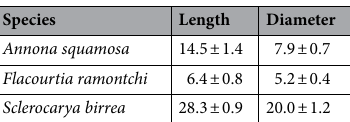
Table 3. Mean seed sizes (with standard deviation) in mm; N = 10 for each